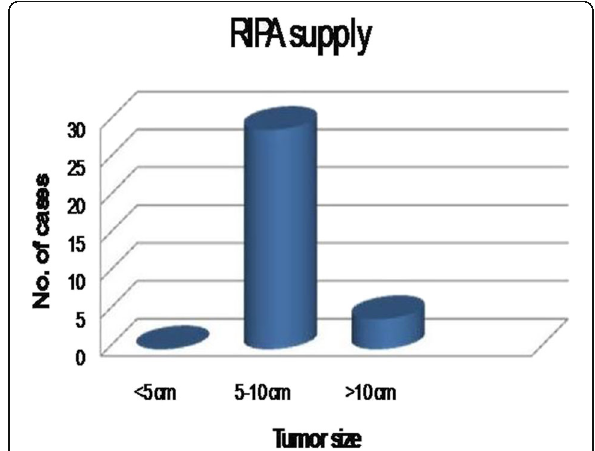
Fig. 3 Prevalence of extrahepatic RIPA supply according to tumor size in our